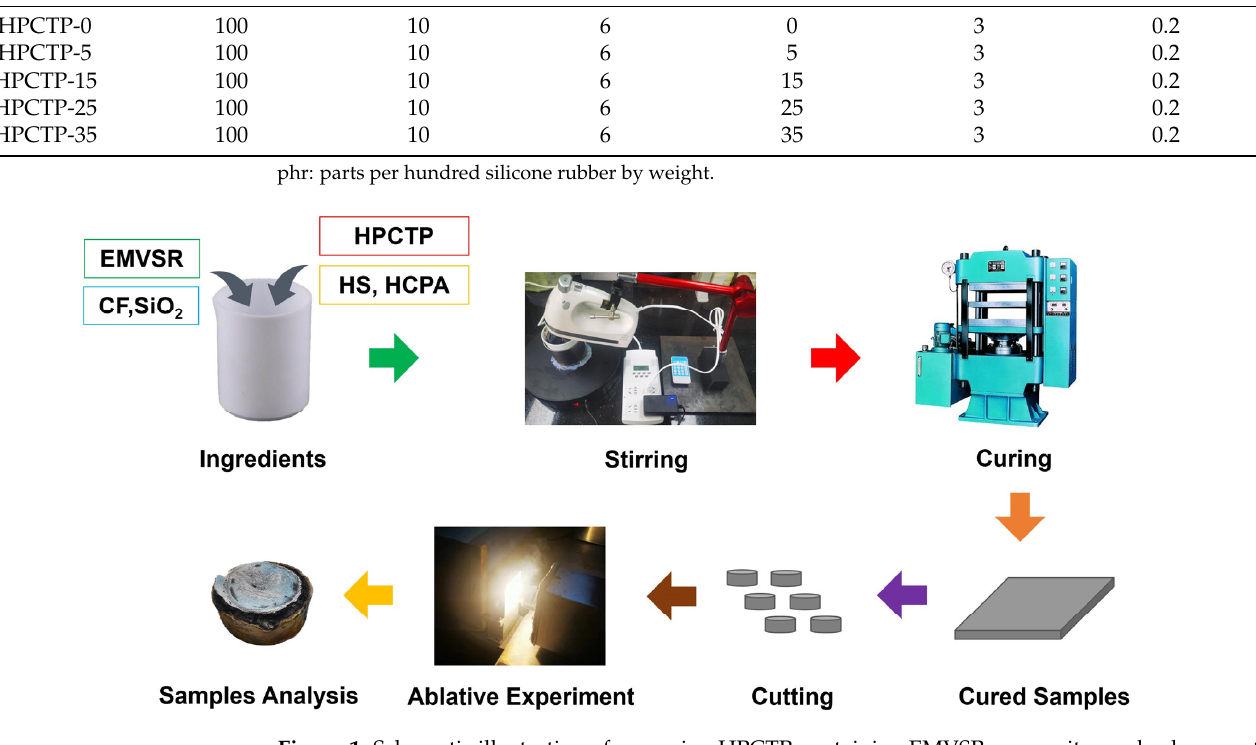
Figure 1. Schematic illustration of preparing HPCTP-containing EMVSR composites and subsequent ablation tests.